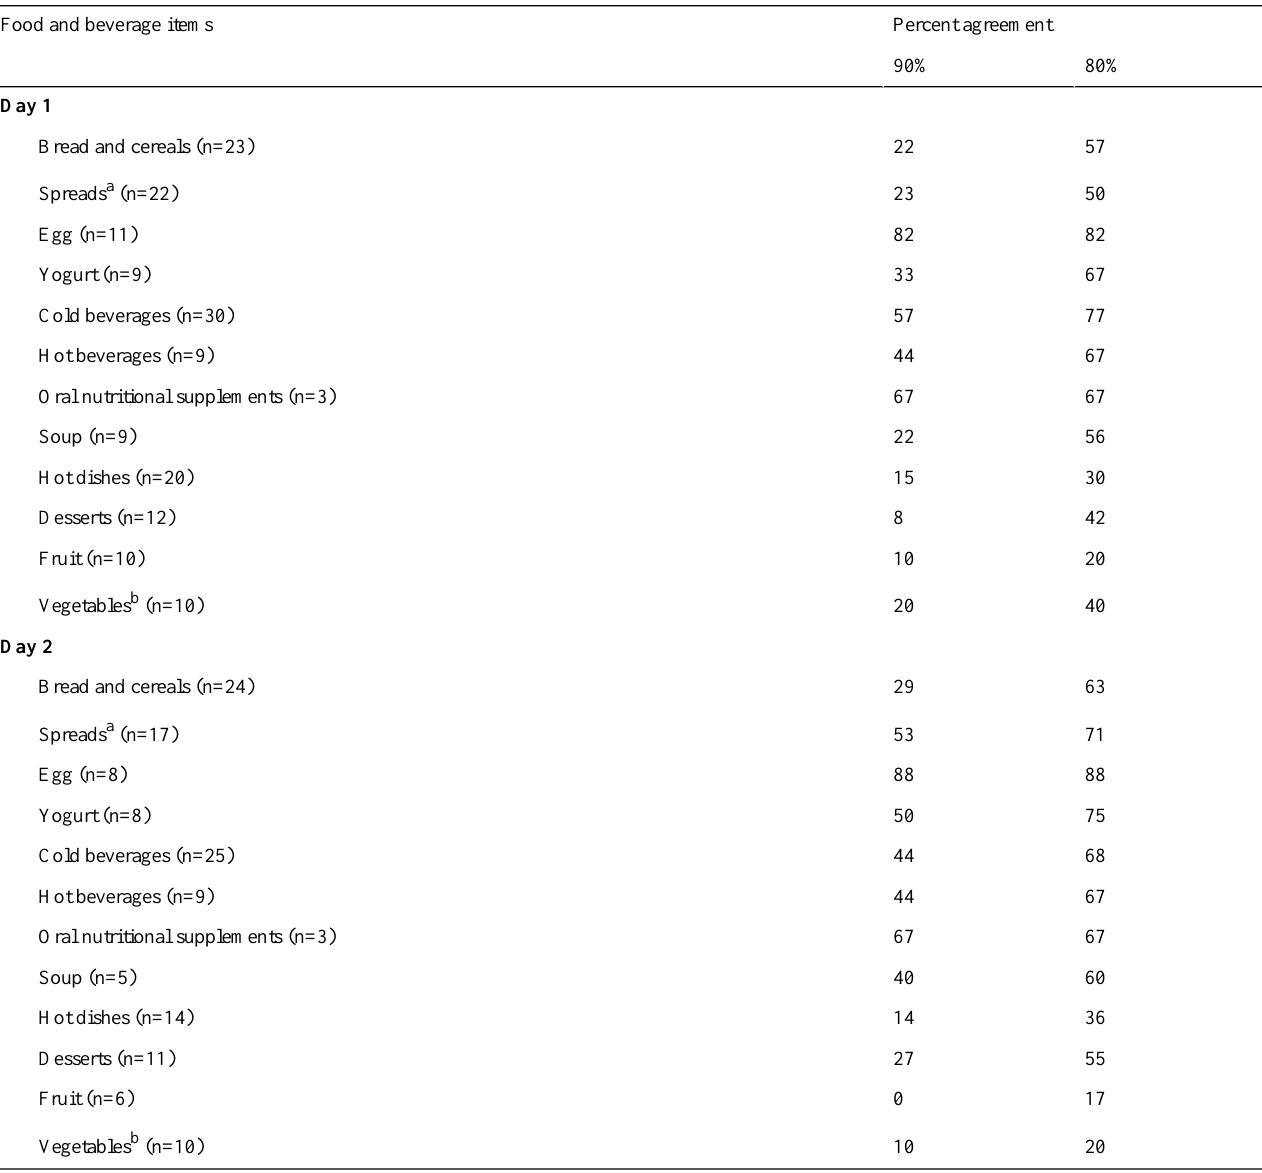
Table 5. Proportions with 90% and 80% agreement between MyFood and the photograph method in estimated intake within food groups.